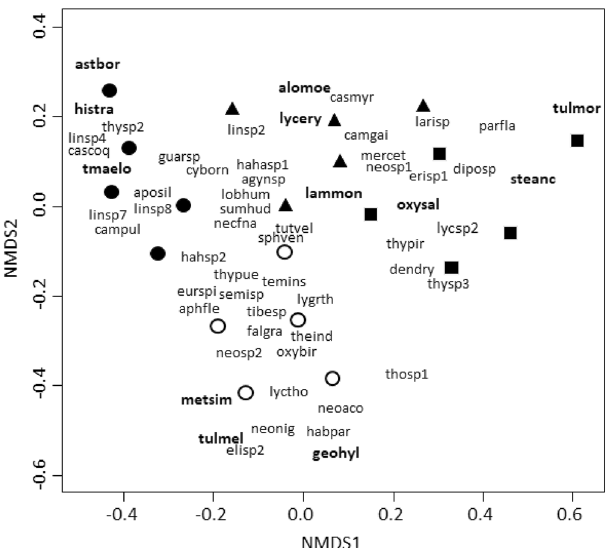
Figure 5. Nonmetric multidimensional scaling (NMDS) ordination in two dimensions of land-use sites and seminatural grasslands based on the similarity of species composition. Species are represented by their name’s abbreviations (Appendix, Table A1), black circles are tree plantation sites, white circles are seminatural grassland sites, triangles are cattle fields and squares are soybean crops. In bold species that presented the strongest association with the different land-use types based on NMDS scores.